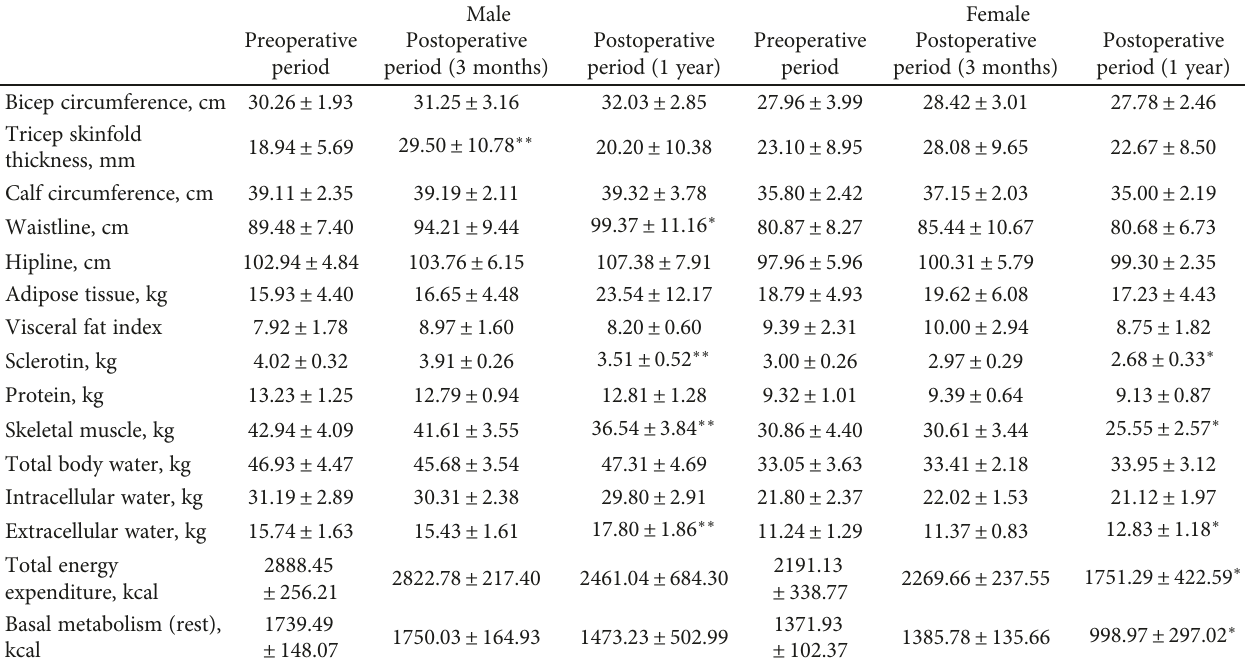
Table 3: Body composition and metabolic changes in the acromegaly patients according to gender.